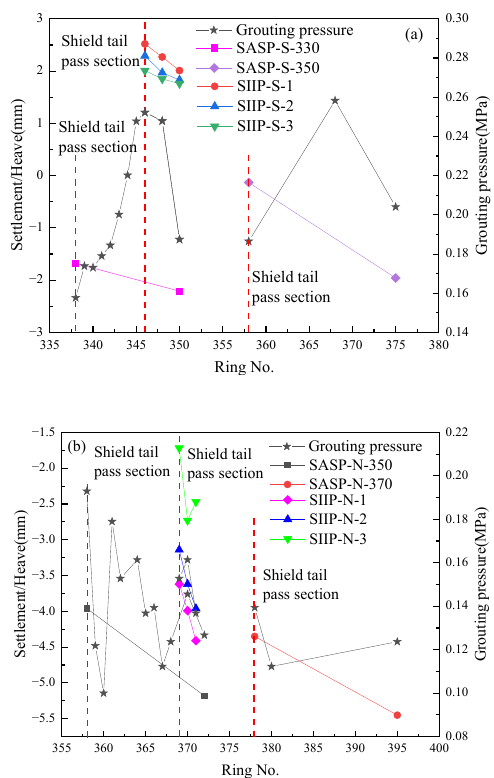
Figure 19. Relationship between surface deformation and grouting pressure: ( a ) south line; ( b ) north line.